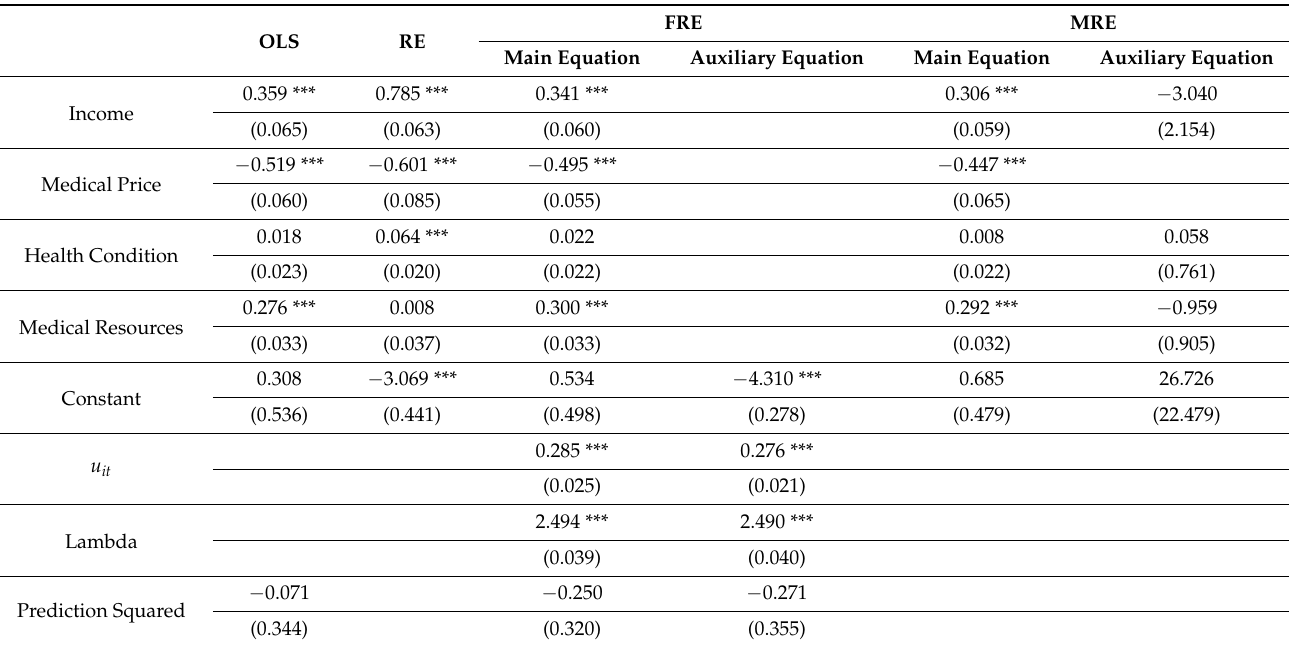
Table 3. Test for the MRE